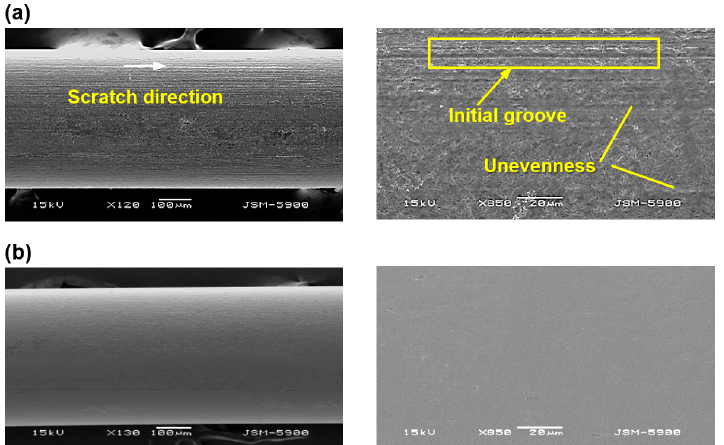
Figure 8. SEM images of a workpiece surface finished with grapeseed oil (particle size 1 µm, rotational speed 1000 rpm, finishing time 180 s, and magnification ×130, 850): ( a ) Before the finishing process; ( b ) After the finishing process.